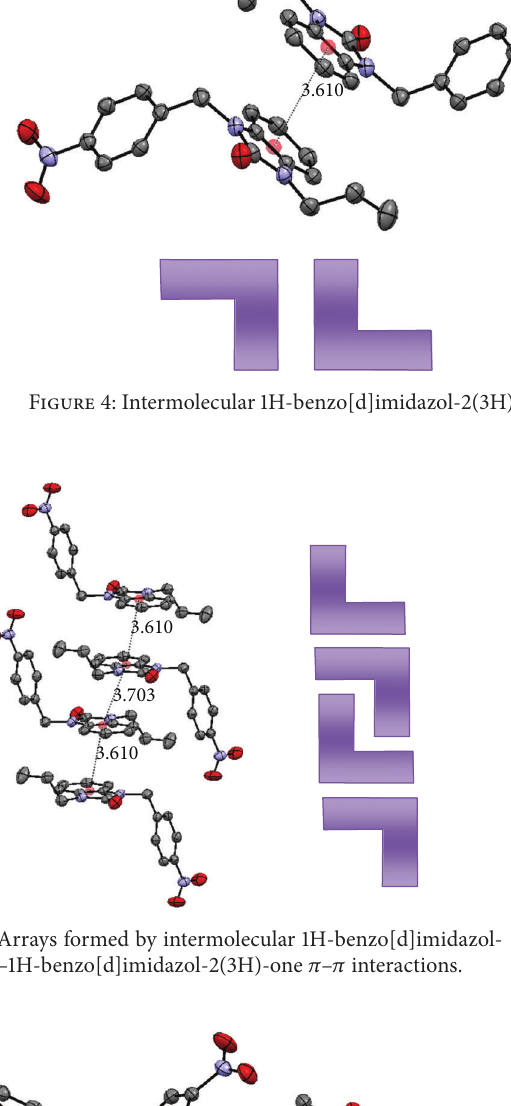
Figure 6: Intermolecular 𝜋 – 𝜋 interactions.